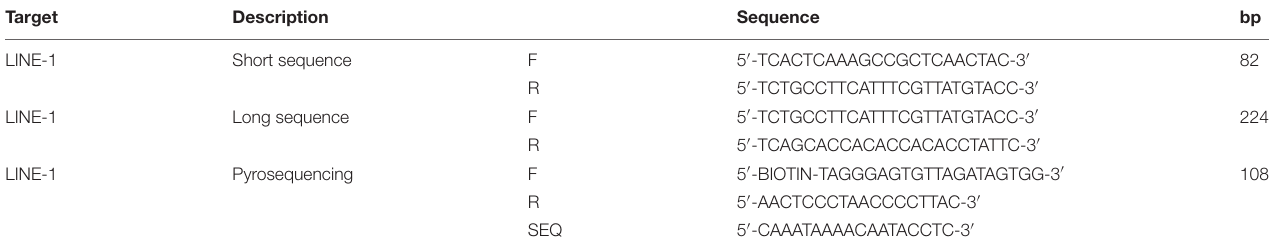
TABLE 4 | List of primers used along with their amplicon